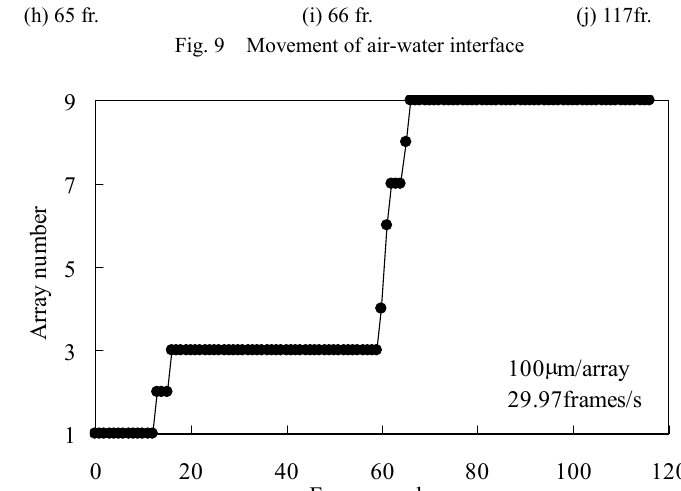
Fig. 9 Movement of air-water interface